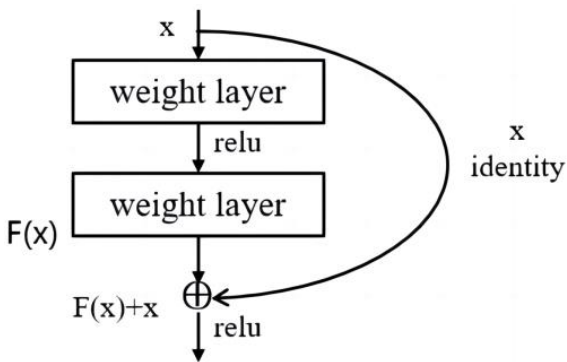
Figure 1. Residual unit.